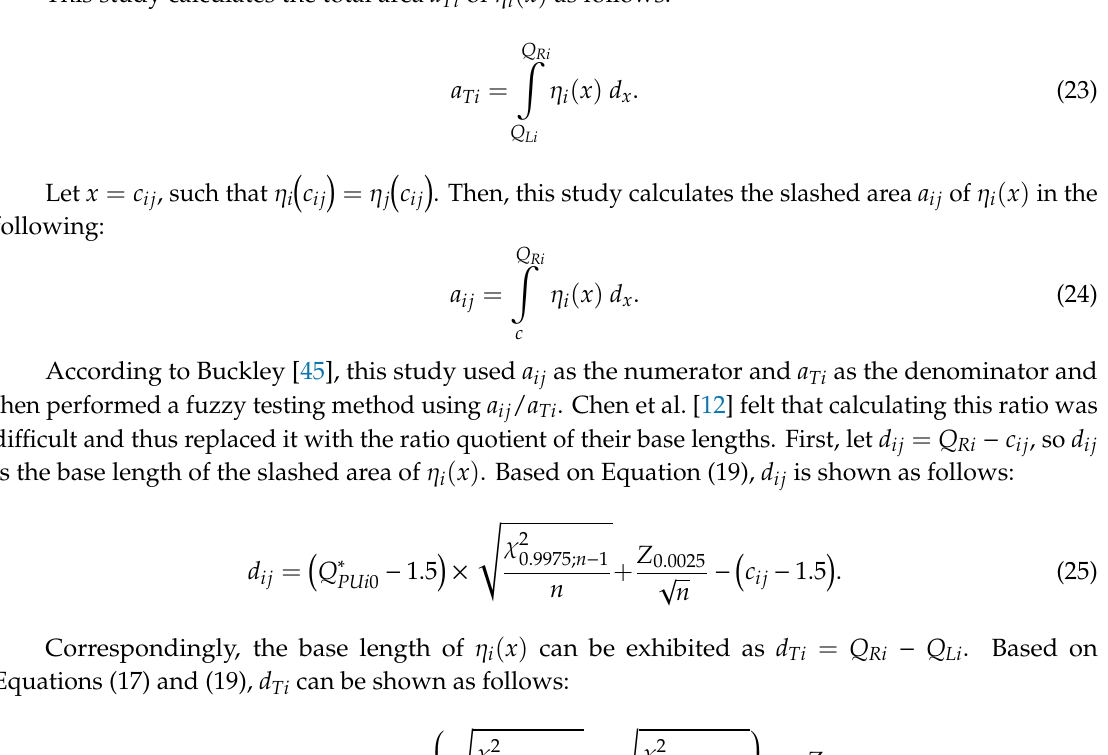
Figure 2. Membership functions of η i ( x ) and η j ( x ) with Q ∗